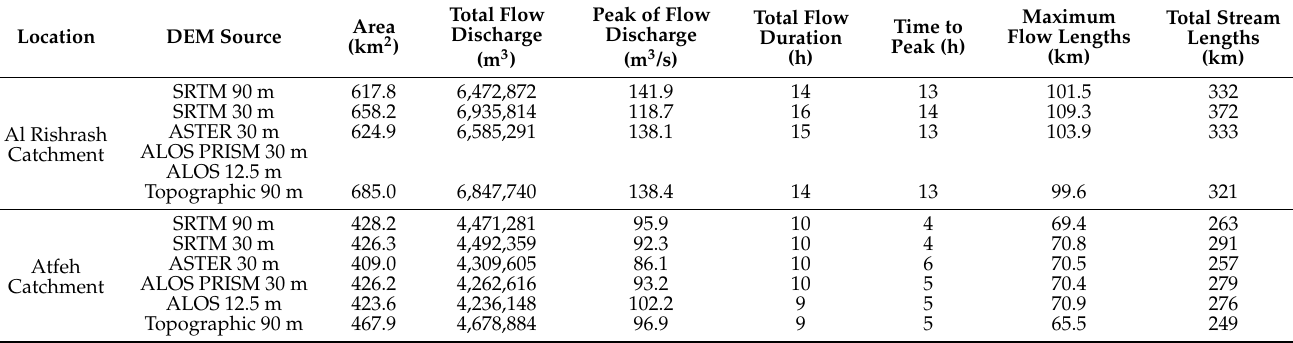
Table 1. Morphometric parameters of the different drainage